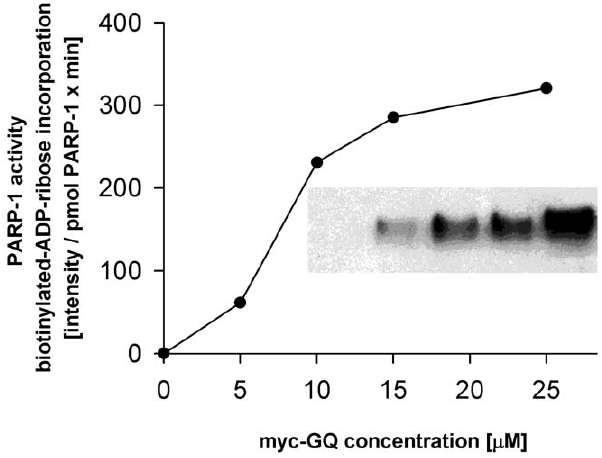
Figure 1. Invitro binding of h PARP-1 to the h c-myc GQ structure and the effect of TMPyP4 on that binding. Figure 1A Effect of TMPyP4 on the binding of PARP-1 to the c-myc GQ structure. 0.45 pmol aliquots of h PARP-1 were incubated with 5 pmols of 5 9 -biotine end-labeled wild type h c-myc GQ oligonucleotide (wild type GQ, 5 9 -biotin-TGG GGA GGG TGG GGA GGG TGG GGA AGG) in the absence and in the presence of different concentrations of the cationic porphyrin compound TMPyP4 as described in the Materials and Methods. Binding is expressed as % of binding measured in the absence of competing TMPyP4 and is shown on the ordinate. TMPyP4 concentrations (0, 0.58, 2.9, 14.4, and 72 m M) are shown on the abscissa. Asterisks represent samples where the extent of binding are significantly different (p , 0.05, Student t-test). Figure 1B In vitro binding of h PARP-1 to various GQ structures and the competing effect of TMPyP4 on that binding. 0.45 pmol aliquots of h PARP-1 were incubated either with 5 pmols h telomeric GQ structure (h-telomeric GQ, 5 9 -biotin-TTA GGG TTA GGG TTA GGG TTA GGG) or with wild type c-myc GQ structure (wild type GQ, 5 9 -biotin-TGG GGA GGG TGG GGA GGG TGG GGA AGG) or its mutants (mutant-1 GQ, 5 9 -biotin-TGG GGA GGG TG A GGA GGG TGG GGA AGG, mutant-2 GQ, 5 9 -biotin-TG A GGA GGG TGG GGA G A G TGG GGA AGG). The sites of mutations are shown in bold. Binding assay was carried out as described in Materials and Methods. Ordinate shows the binding of PARP-1 to GQ structures (telomeric GQ, c-myc GQ, G-131A and G-140, -126A) expressed in percentage. The amount of PARP-1 bound to telomeric GQ is taken as 100%. Insert shows the applied concentrations of TMPyP4. Asterisks represent samples where the difference in binding is significantly different (p , 0.05).